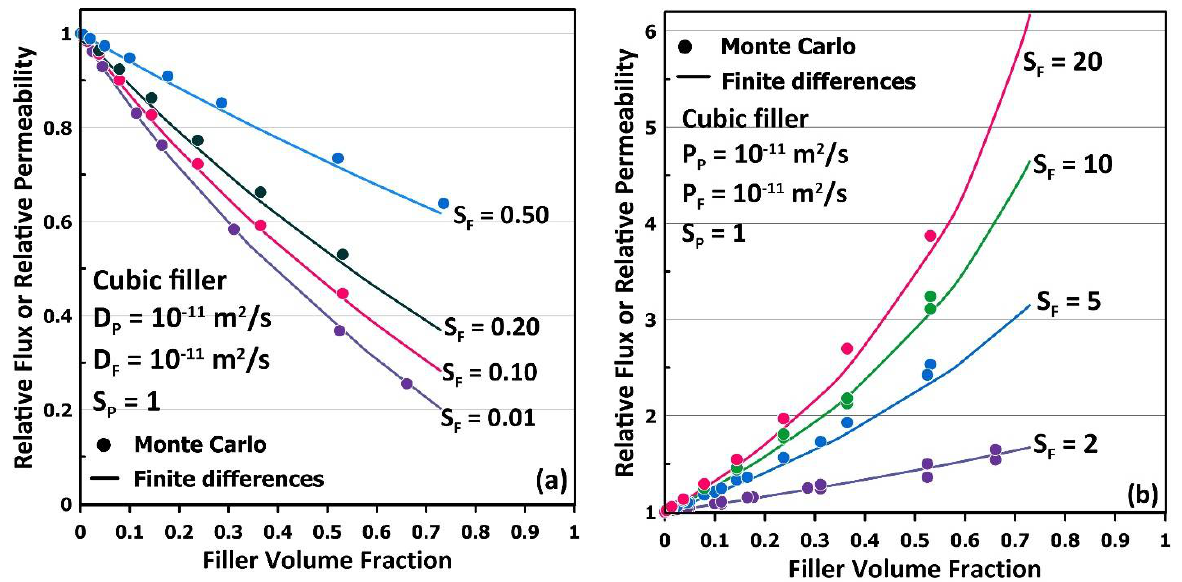
Figure 8. The plot of the relative steady-state flux or relative permeability of an MMM with a cubic filler particle for ( a ) four different filler solubility coefficients lower than the solubility of the polymer and ( b ) four different filler solubility coefficients higher than the solubility of the polymer. Results are compared with the results of the FD method under identical conditions.